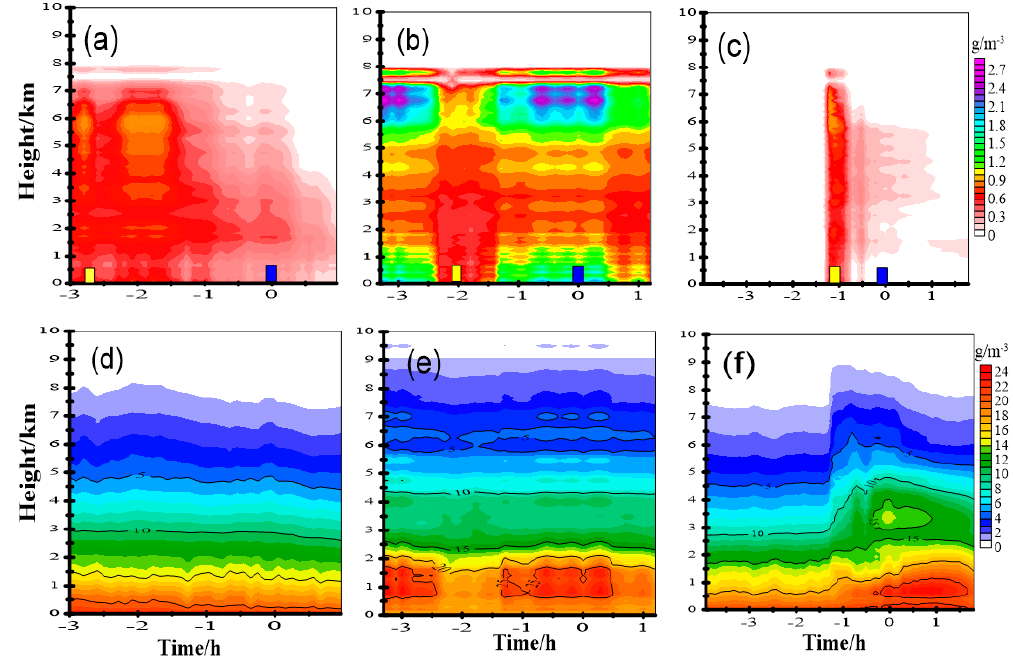
Figure 8. Evolution of liquid cloud content ( a,b,c ) and vapor density ( d,e,f ) for Case 1, Case 2, and Case 3 (shade, unit: g ⋅ m − 3 , yellow box: the time of precipitation peak; blue box: the time of lightning peak). Table 4. Time of precipitation and CG flashes peak in three